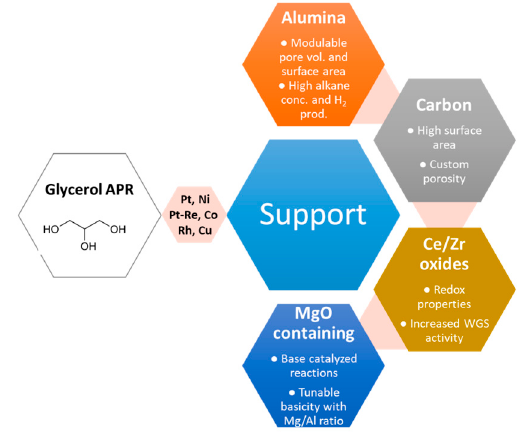
Figure 2. Most used supports in glycerol APR and their main features.